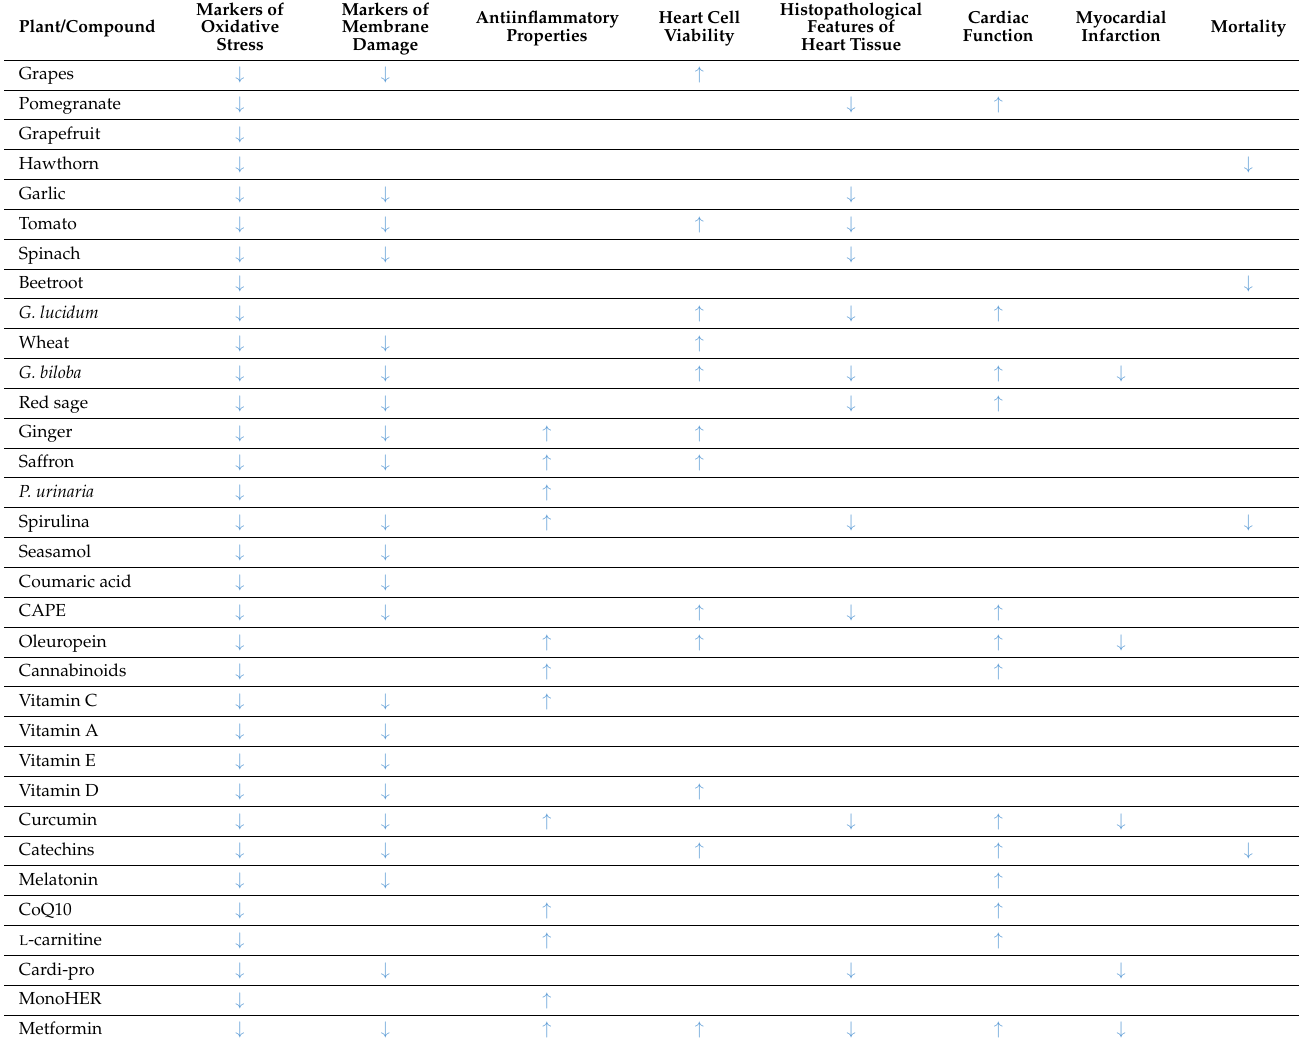
Table 17. Cardioprotective mechanisms of natural products and synthetic